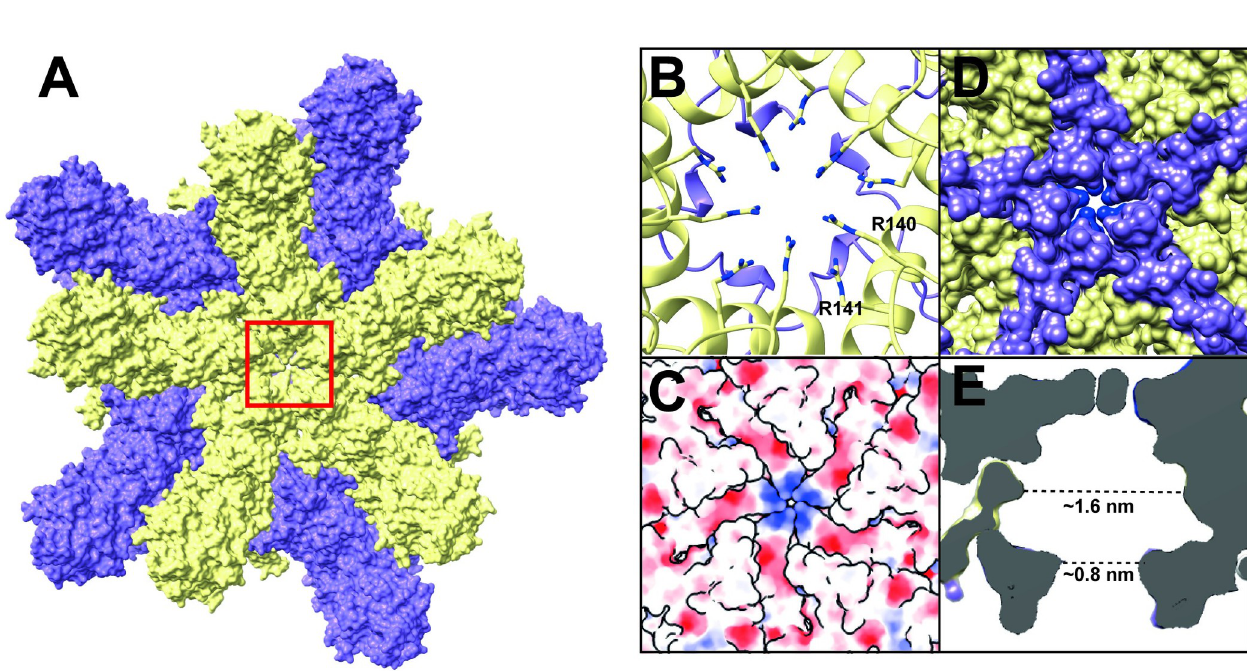
Fig 8. Structure of an obstructed pore and its properties. A) Top view of the 5-fold obstructed pore. MCP_A and B subunits are colored yellow and purple, respectively. B) Close-up view (front view). The obstructing R140 and R141 residues of the MCP_A subunits are shown as stick representation. C) Electrostatics surface of the 5-fold pore. D) Backside view of the 5-fold pore. The C-terminal arm of the MCP_B subunits is colored purple. E) Cross-section of the obstructed pore. The dashed lines indicate the calculated pore size in diameter.